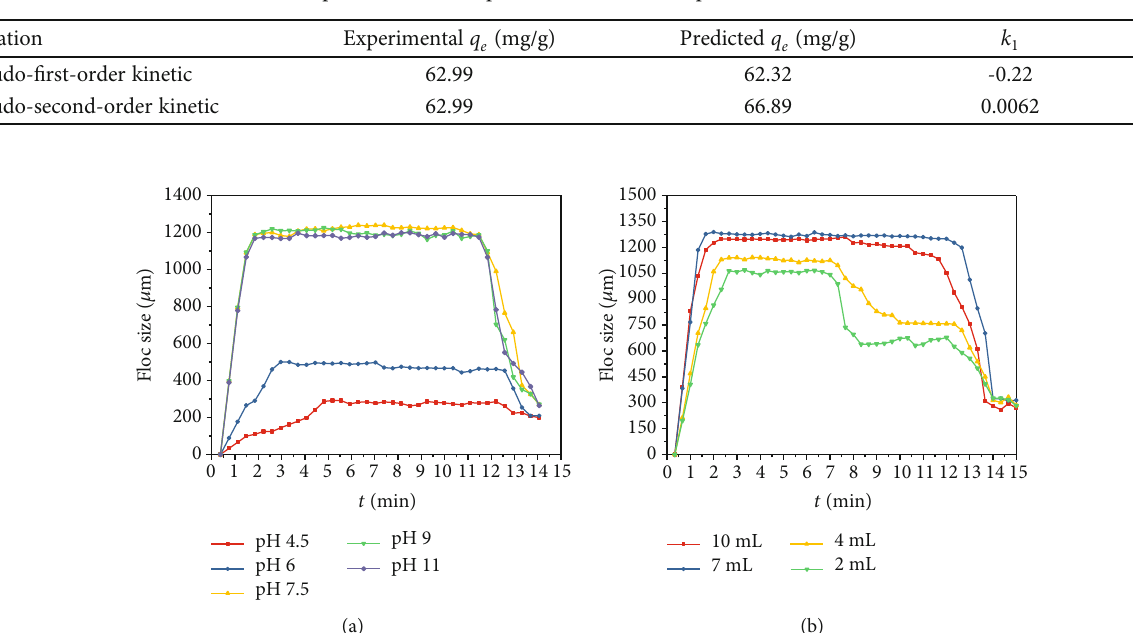
Table 1: The parameters of the pseudo- fi rst-order and pseudo-second-order kinetics.